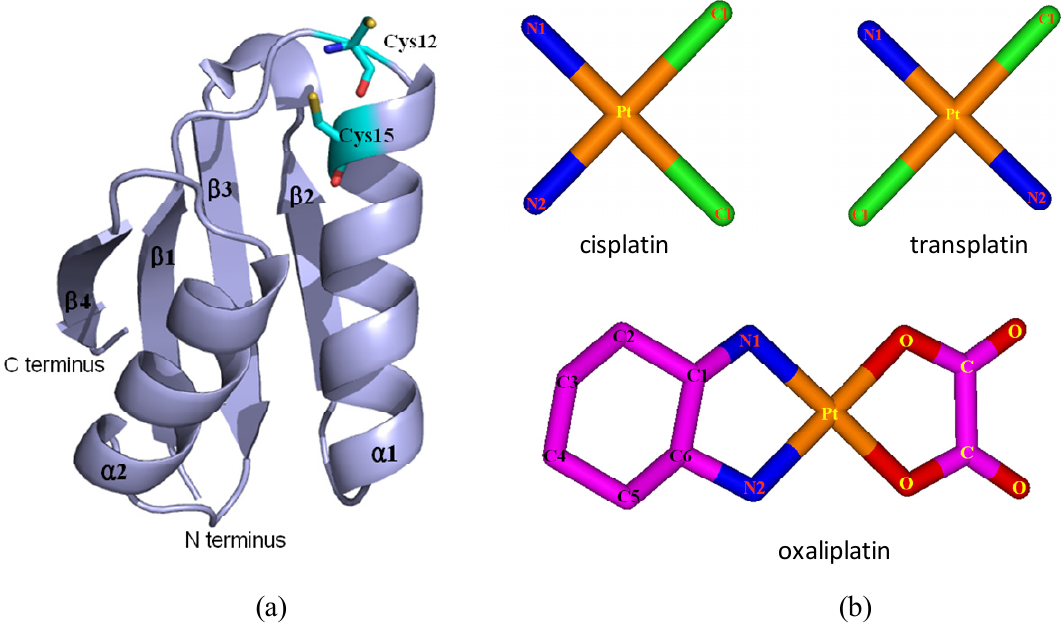
Figure 3. The average structures of ( a ) the CisPt + Atox1 model; ( b ) the TransPt + Atox1 model; and ( c ) the OxaliPt + Atox1 model (Pt: orange; N: deep blue; C: cyan/magenta; S: yellow; O: red; H: